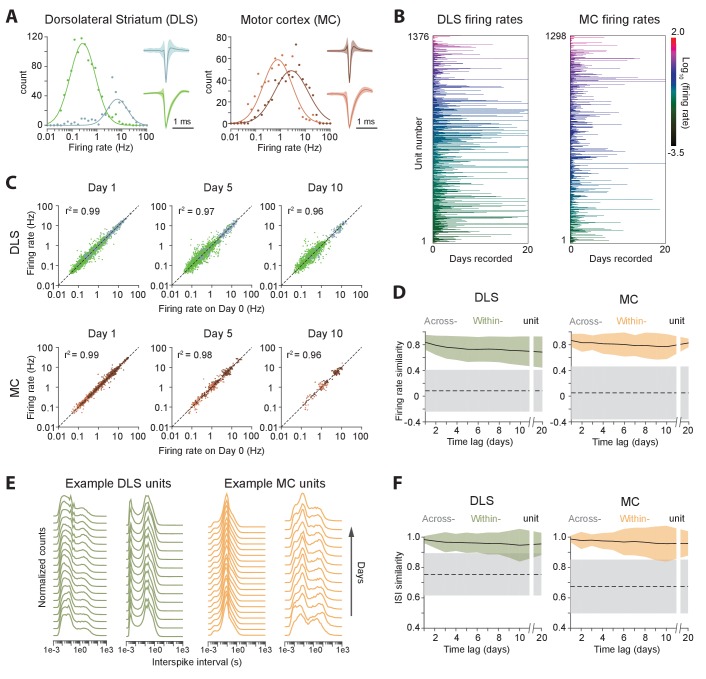
Long-term stability of single unit activity.(A) Histograms of average firing rates for units recorded in DLS (left) and MC (right). Putative cell-types, medium spiny neurons (MSN, blue) and fast-spiking interneurons (FSI, green) in DLS, and regular spiking (RS, brown) and fast spiking (FS, red) neurons in the MC, were classified based on spike shape and firing rate (Materials and methods). The continuous traces are log-normal fits to the firing rate distributions of each putative cell-type. Insets show average peak-normalized waveform shapes for MSNs (left-bottom) and FSIs (left-top), and RS (right-bottom) and FS (right-top) neurons. Shading represents the standard deviation of the spike waveforms. (B) Firing rates of DLS (left) and MC (right) units over 20 days of recording. The color scale indicates firing rate on a log-scale, calculated in one-hour blocks. Units have been sorted by average firing rate. (C) Scatter plots of unit firing rates over time-lags of 1 (left), 5 (middle) and 10 (right) days for DLS (top) and MC (bottom). The dashed lines indicate equality. Every dot is a comparison of a unit’s firing from a baseline day to 1, 5 or 10 days later. The color of the dot indicates putative cell-type as per (A). Each unit may contribute multiple data points, depending on the length of the recording. Day 1: n = 4398 comparisons for striatum and n = 1458 for cortex; Day 5: n = 2471 comparisons for striatum and n = 615 for cortex; Day 10: n = 1347 comparisons for striatum and n = 268 for cortex. (D) Stability of unit firing rates over time. The firing rate similarity (see Materials and methods) was measured across time-lags of 1 to 20 days for the same unit (within-unit, solid lines), or between simultaneously recorded units (across-unit, dashed lines) in DLS (left) and MC (right). Colored shaded regions indicate the standard deviation of within-unit firing rate similarity, over all units. Grey shaded regions indicate standard deviation of across-unit firing rate similarity, over all time-bins. (E) Inter-spike interval (ISI) histograms for example units in DLS (left, green) and MC (right, orange) over two weeks of continuous recordings. Each line represents the normalized ISI histogram measured on a particular day. (F) Stability of unit ISI distributions over time. Correlations between ISI distributions were measured across time-lags of 1 to 20 days for the same unit (within-unit, solid lines), or between simultaneously recorded units (across-unit, dashed lines) in DLS (left) and MC (right). Colored shaded regions indicate the standard deviation of within-unit ISI similarity, over all units. Grey shaded regions indicate standard deviation of across-unit ISI similarity, over all time-bins.